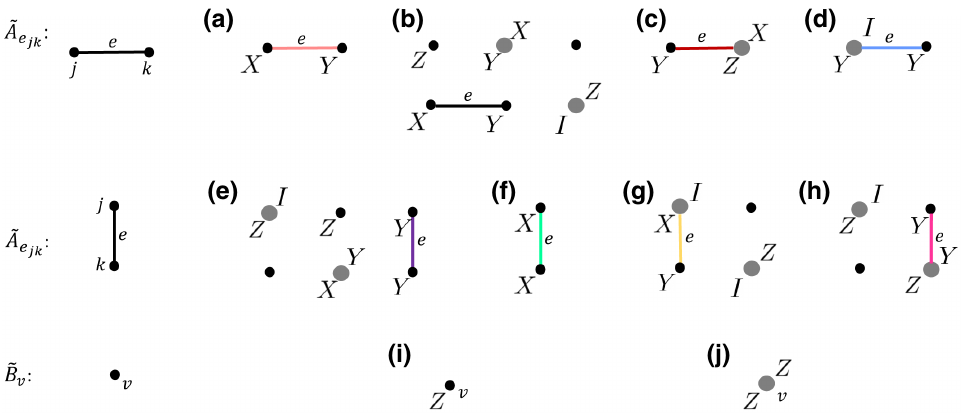
˜ FIG. 26. The hopping term A e and the parity term ˜ B v in the bosonic Hilbert space. The definitions of of edges and vertices. (a)–(d) Four kinds of horizontal hopping terms; (e)–(h) four kinds of vertical hopping terms; (i),(j) parity terms on black and gray vertices.